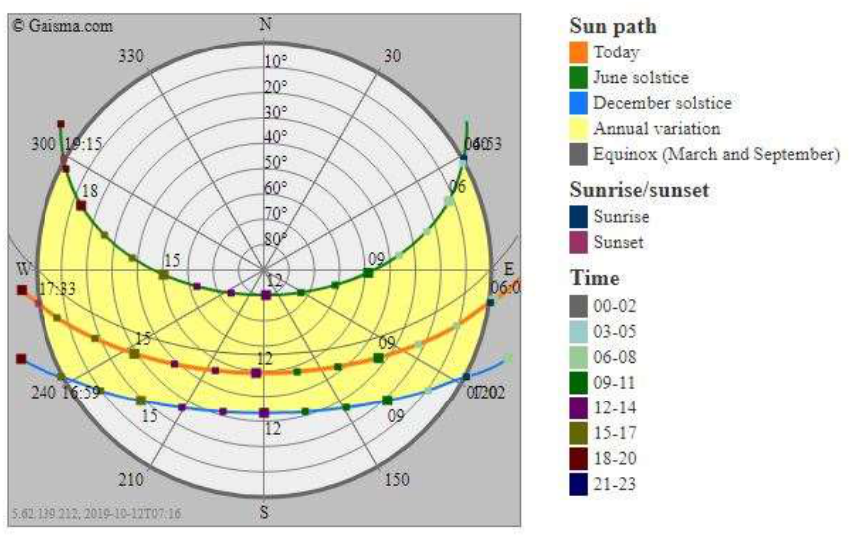
Figure 1: Sun path over Baghdad city throughout the year.